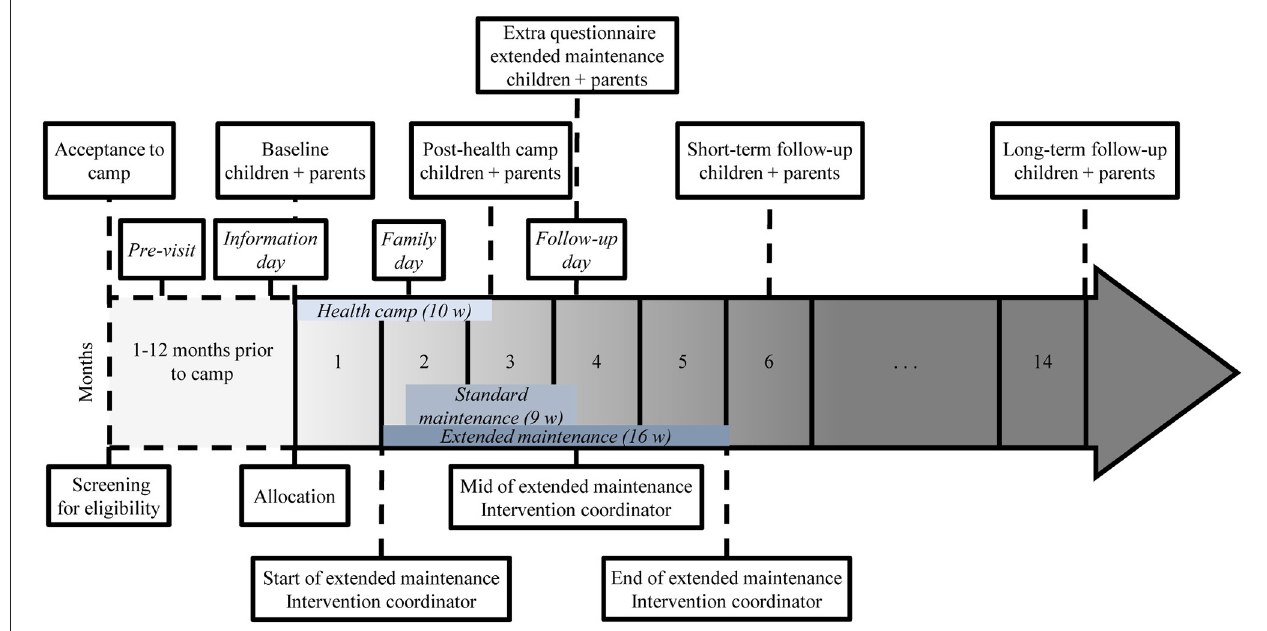
FIGURE 3 | Participant timeline including time points for